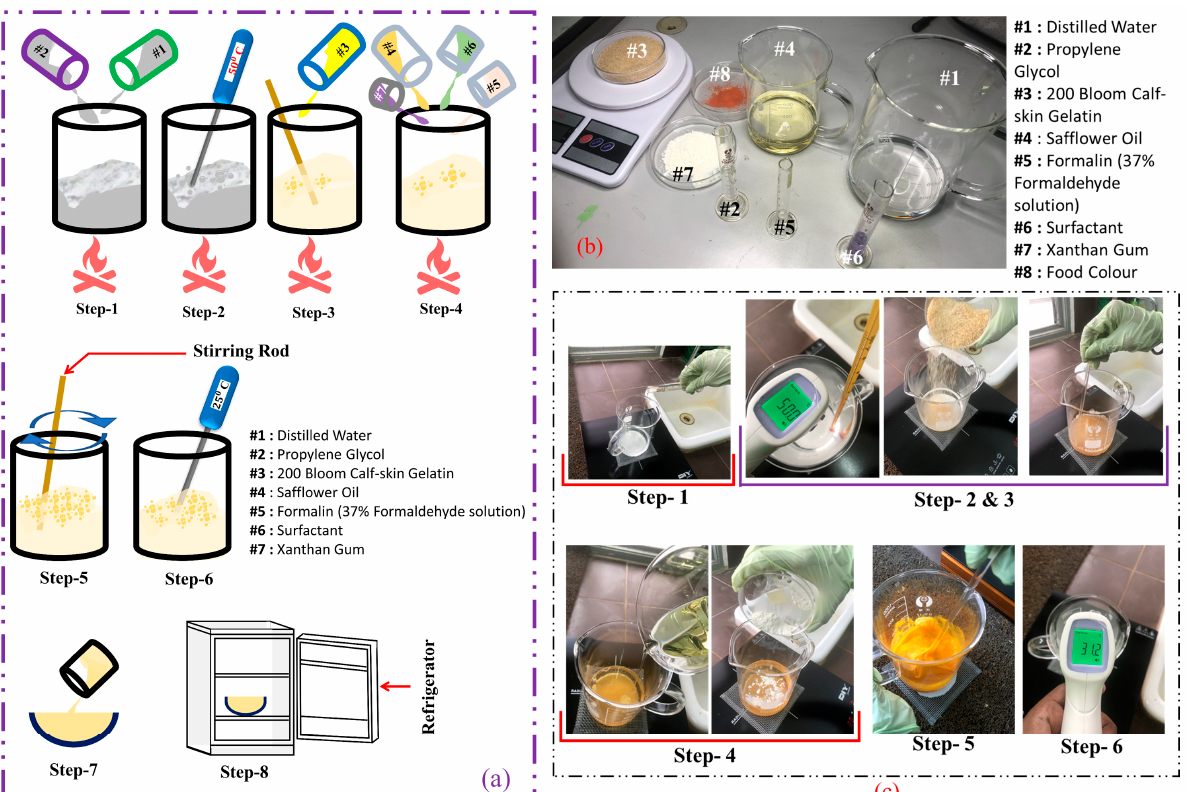
Figure 16. Heterogeneous breast phantom fabrication procedure: ( a ) schematic diagram of fabrica ‐ tion procedure; ( b ) photographic of different materials were used in fabrication processes; ( c ) all the steps were involved to carry out fabrication in laboratory environment.